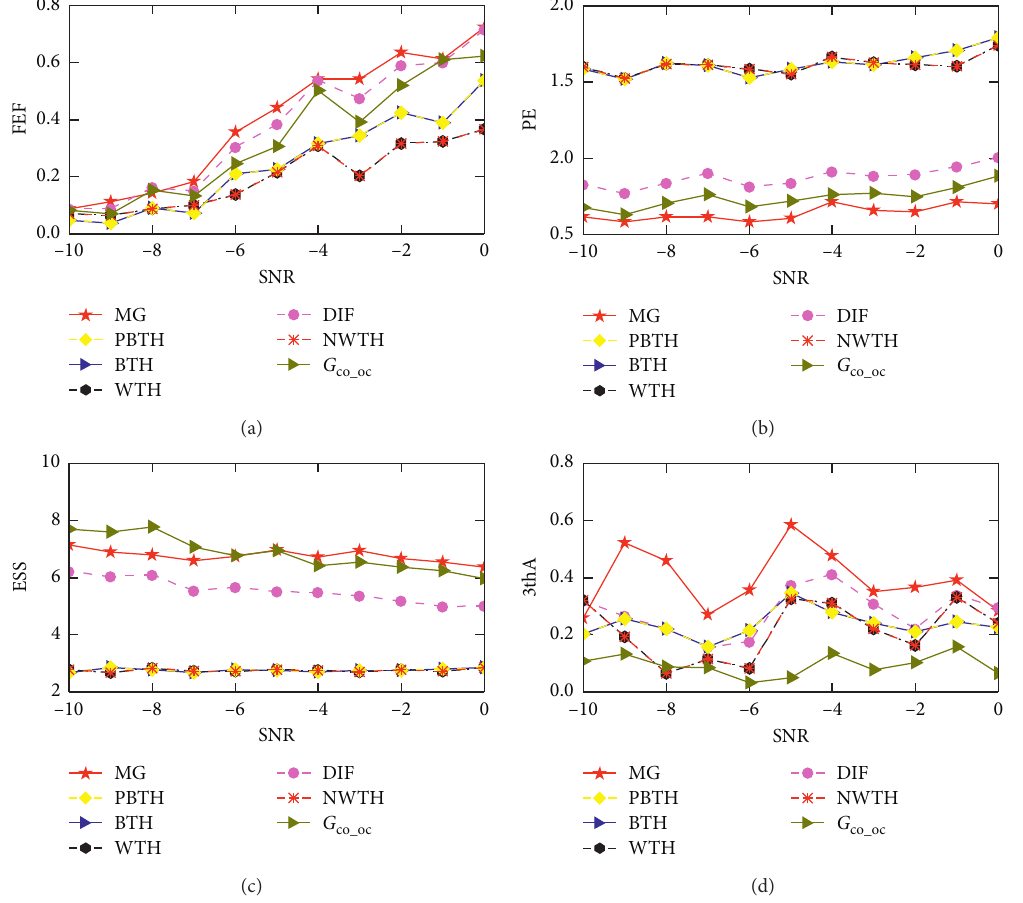
Figure 1: The results of the evaluation indicator varying with SNR: (a) feature energy factor; (b) permutation entropy; (c) envelope spectrum sparsity; (d) 3rd harmonic amplitude.